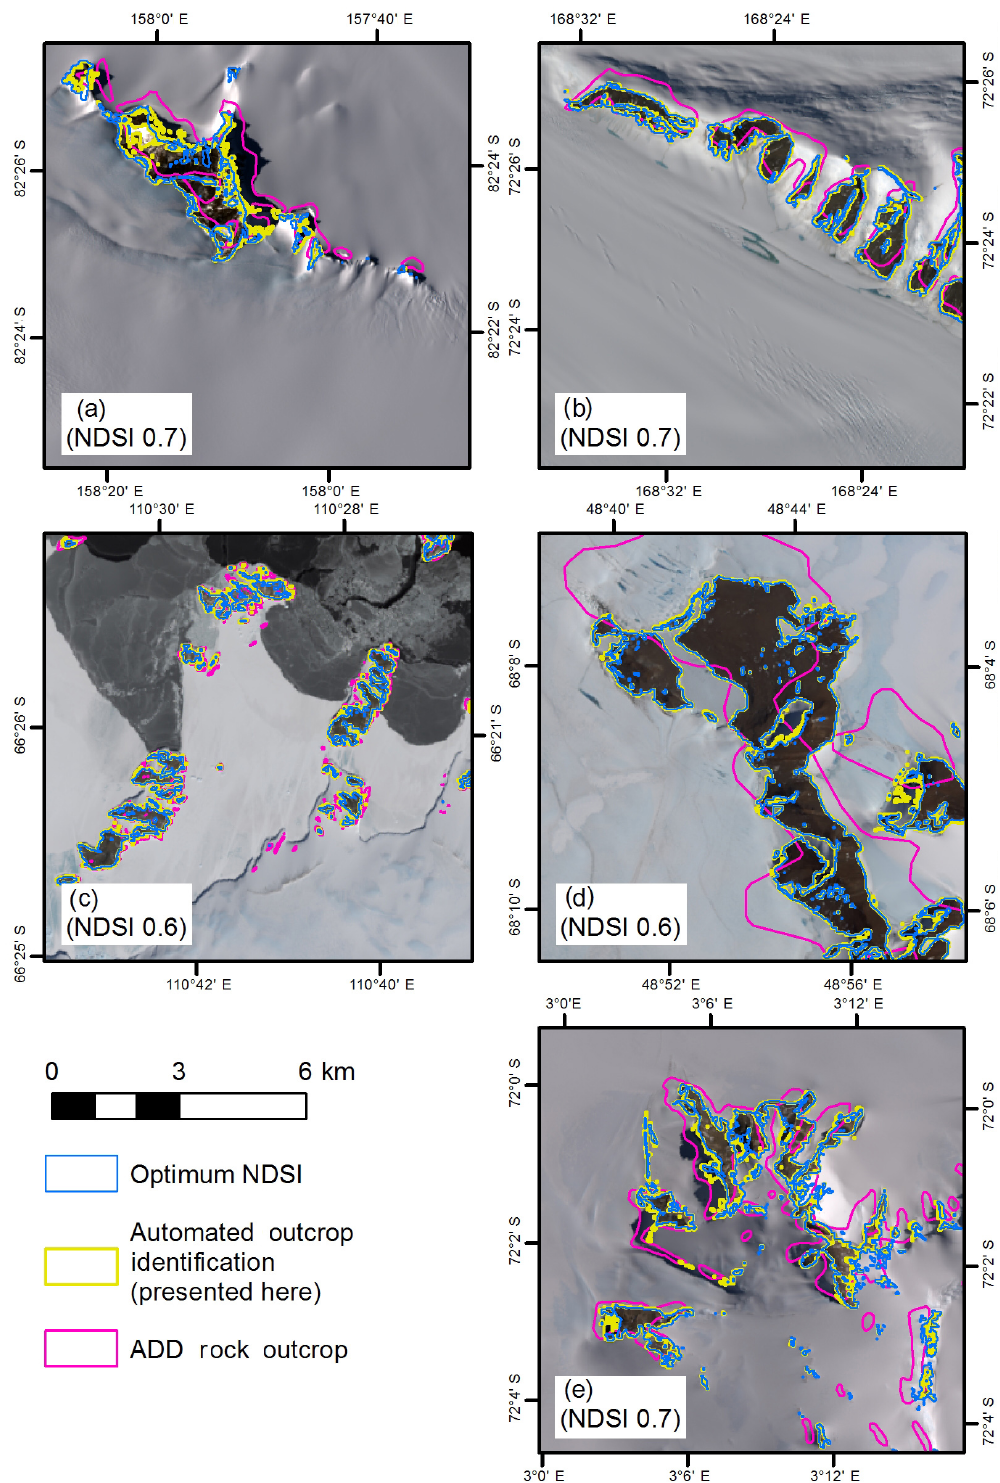
The Cryosphere, 10, 1665–1677, 2016